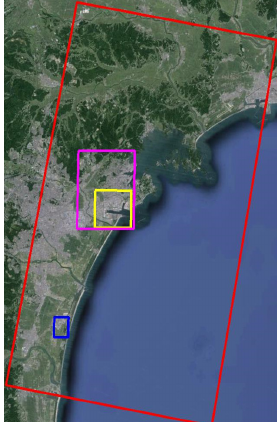
Figure 1. Study area (red square) in Sendai area, Japan. The vertical axis coincides with north-south direction. The red square indicates the border of TSX image acquired on March 12, 2011 (one day after the tsunami). The Sendai harbor (yellow square) is chosen as area for visual analysis based on a multi- temporal false-color image (Section 2.2). With respect to linear- feature change detection using Curvelet-based approach, the pink square indicates the computation area of complex (Section 4.3), and the blue square encircles the one in the second case of broken bridge detection (Section